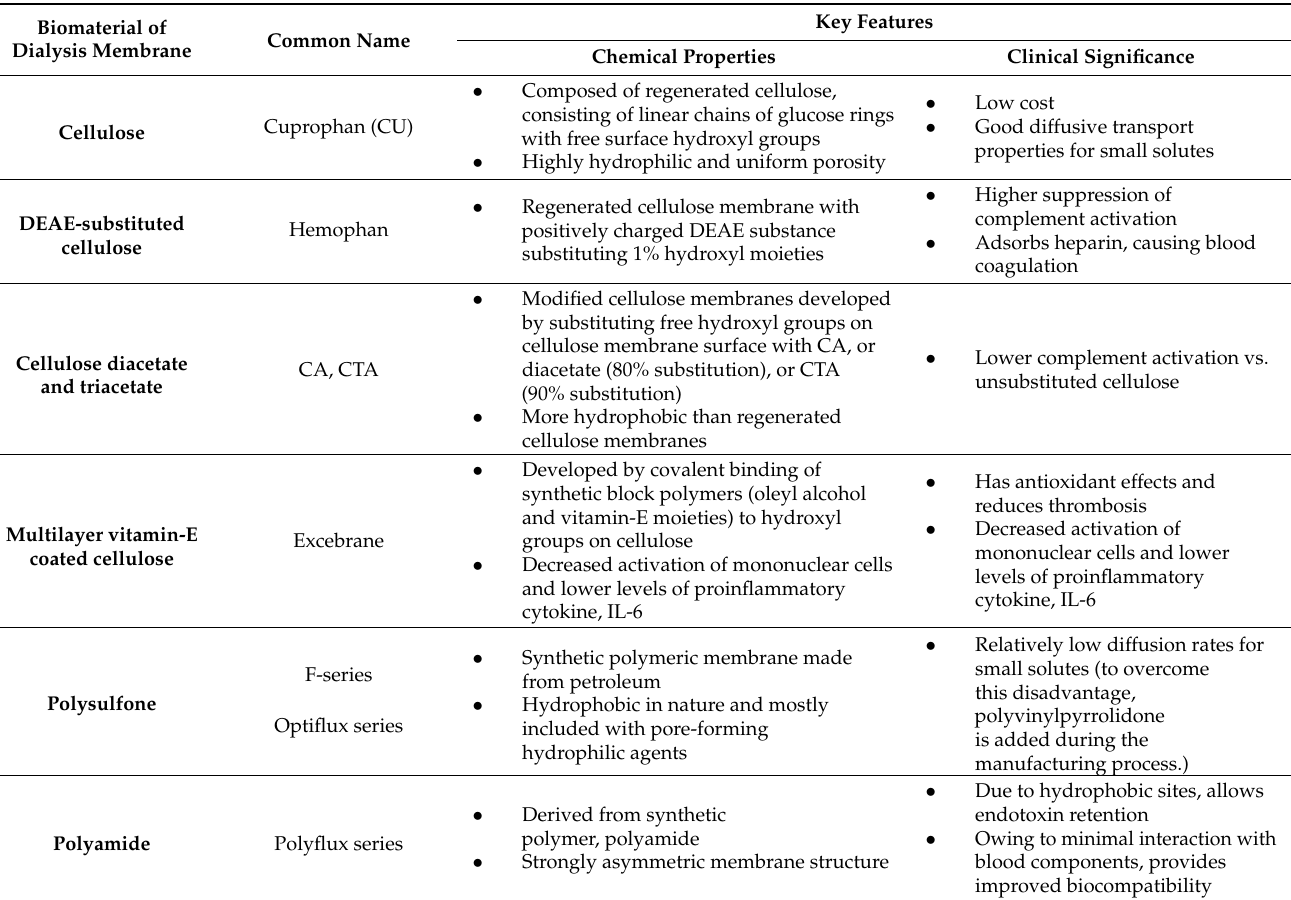
Table 1. Different types of dialysis membranes and their key